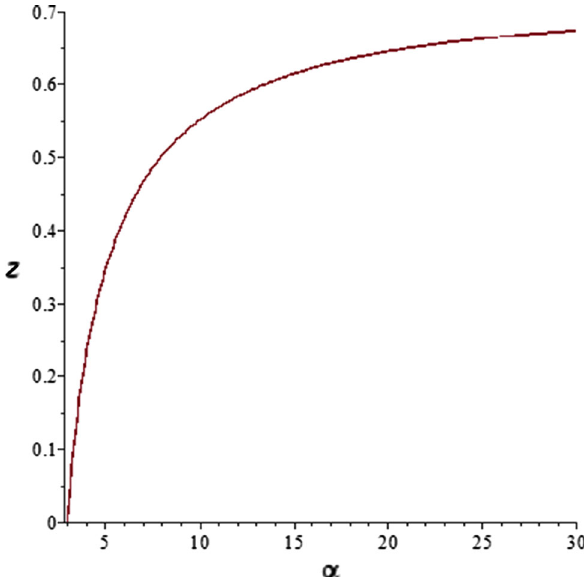
Fig. 4 The gravitational surface redshift versus the parameter α the mass-radius ratio determines one of the two parameters ω and k from (44). If we can also predict the total charge of star, we can fix ω and k separately from (42). For example, when we take the gravitational redshift of the neutron star EXO 0748-676 as z = 0 . 35 with M = 2 M (cid:2) and R = 13 . 1 km [90], we find that α ≈ 5 . 08 from (45) and there is one free parameter k or ω that must be fixed in (44). Then we can fix k = 1 which leads to ω ≈ 0 .